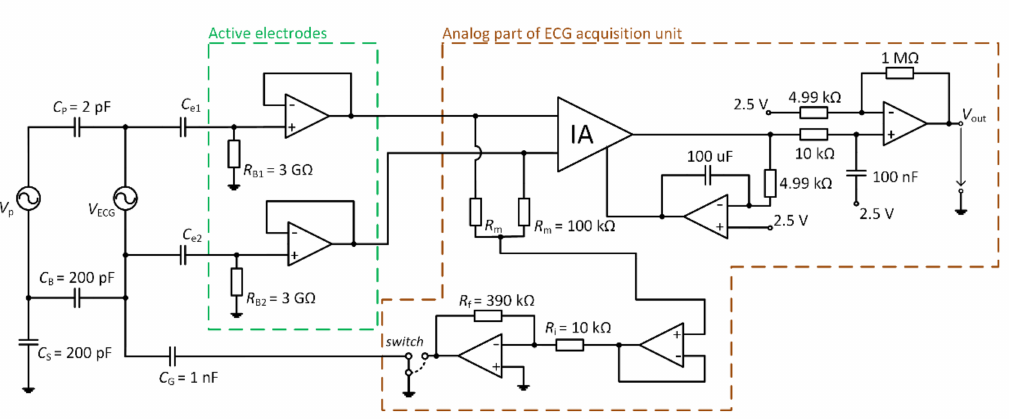
Figure 13. Schematic of the simulation model.